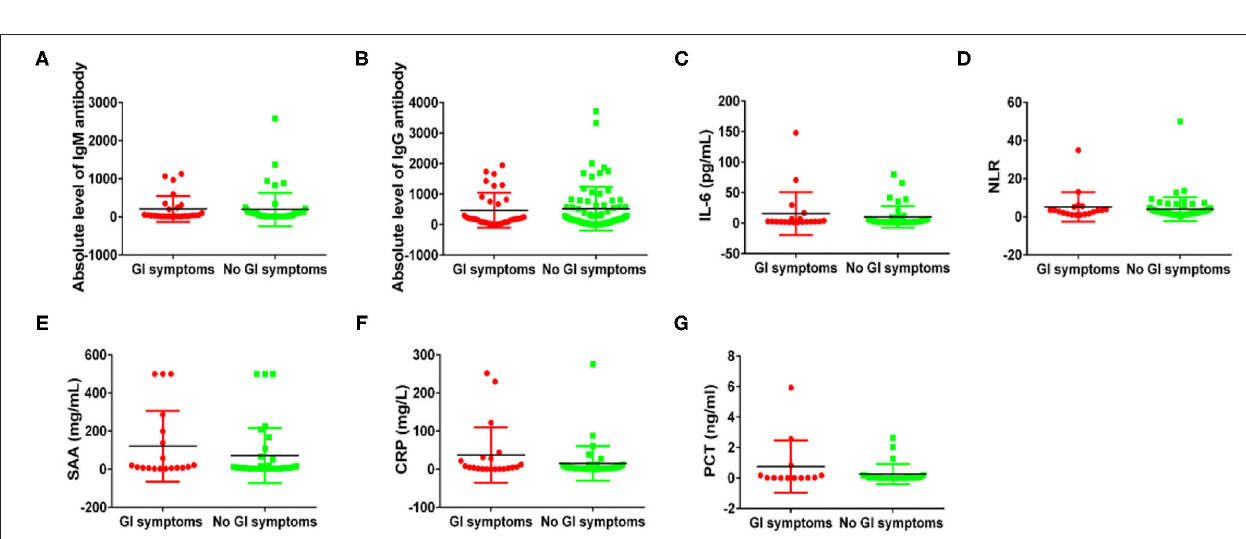
FIGURE 1 | Immune response phenotype in COVID-19 patients with and without GI symptoms according to the percentage of abnormal indicators.